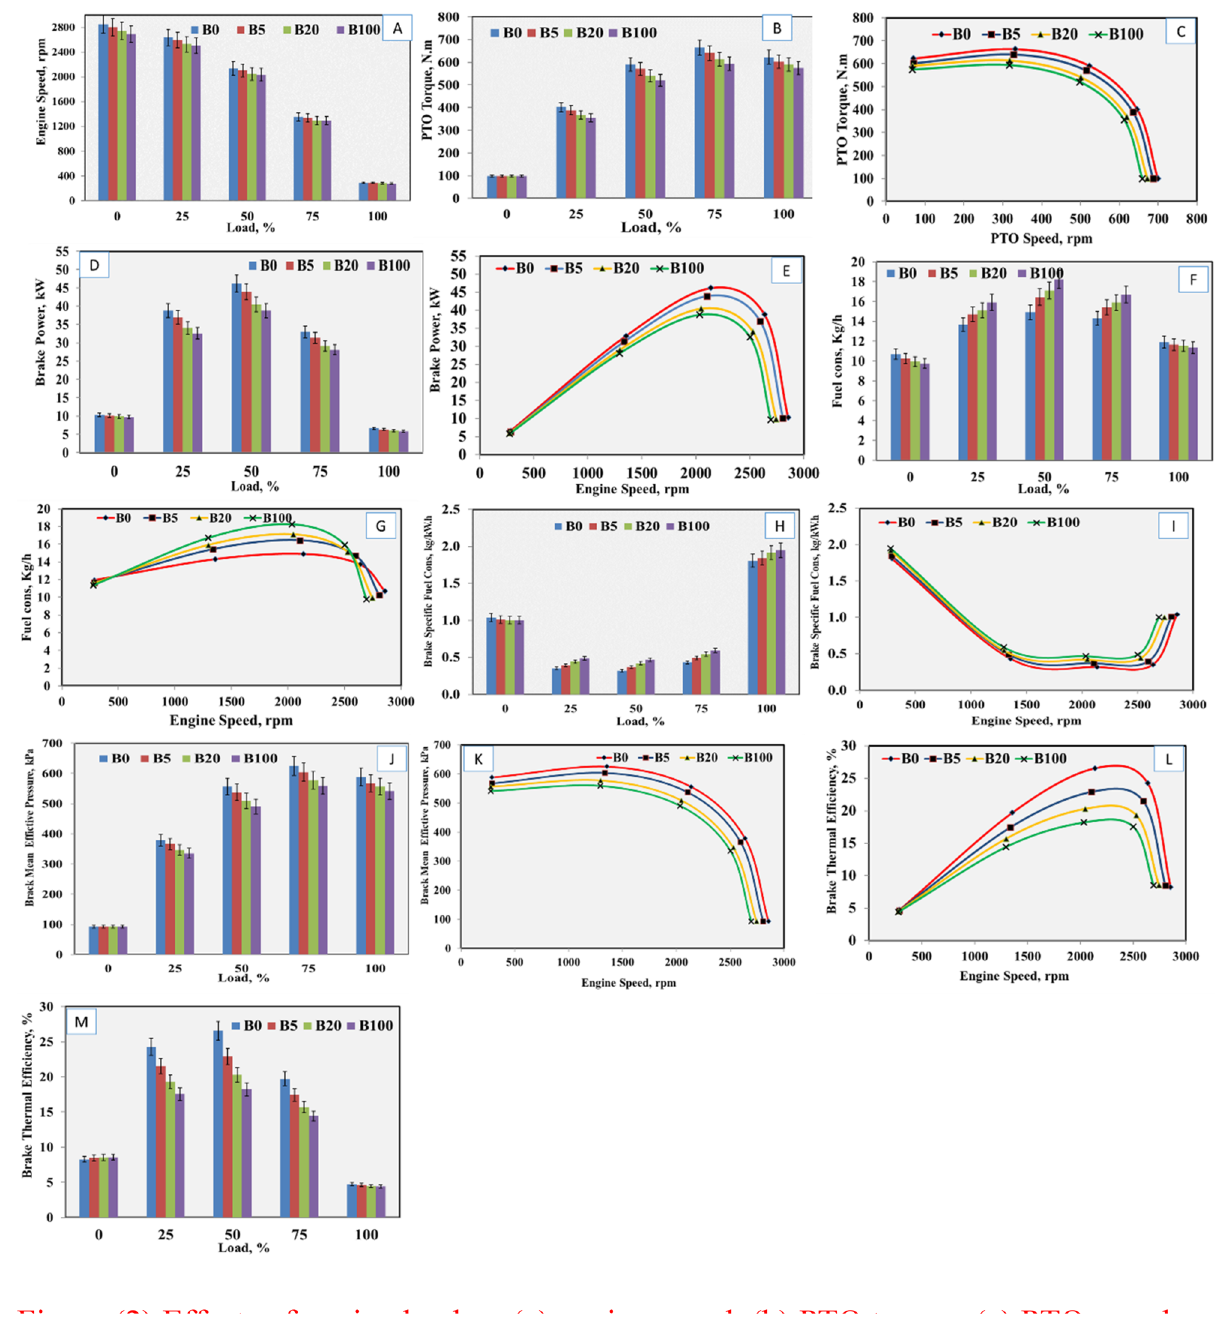
Figure 2. Effects of engine load on ( a ) engine speed, ( b ) PTO torque, ( c ) PTO speed on PTO torque, ( d ) engine load on brake power, ( e ) engine speed on brake power, ( f ) engine load on fuel consumption, ( g ) engine speed on fuel consumption, ( h ) engine load on (BSFC). ( i ) engine speed on (BSFC), ( j ) engine load on BMEP, ( k ) engine speed on BMEP, ( l ) engine speed on BTE and ( m ) engine load on showed a significant effect of engine load percentage and fuel blend percentage and their interaction on all the studied characters. Engine speed. For the effects of engine load percentage on engine speed, the results in Table 1 indicated the relationship between engine load percentage and engine speed in rpm was inversely proportional. The maximum engine speed was recorded at a loading of 0%, and the lowest speed was at a loading of 100% (Table 1). Using 100% diesel fuel (B 0 ) gave the highest engine speed among all treatments, and the lowest speed was recorded with 100% biodiesel fuel (B 100 ). The significant interaction between engine load, percentage, and engine speed in rpm was inversely proportional, as shown in Fig. 2a. The maximum engine speed was 2854 rpm at the load- ing stage of 0% using 100% diesel fuel (B 0 ), while the minimum speed was 276 rpm at the loading stage of 100%